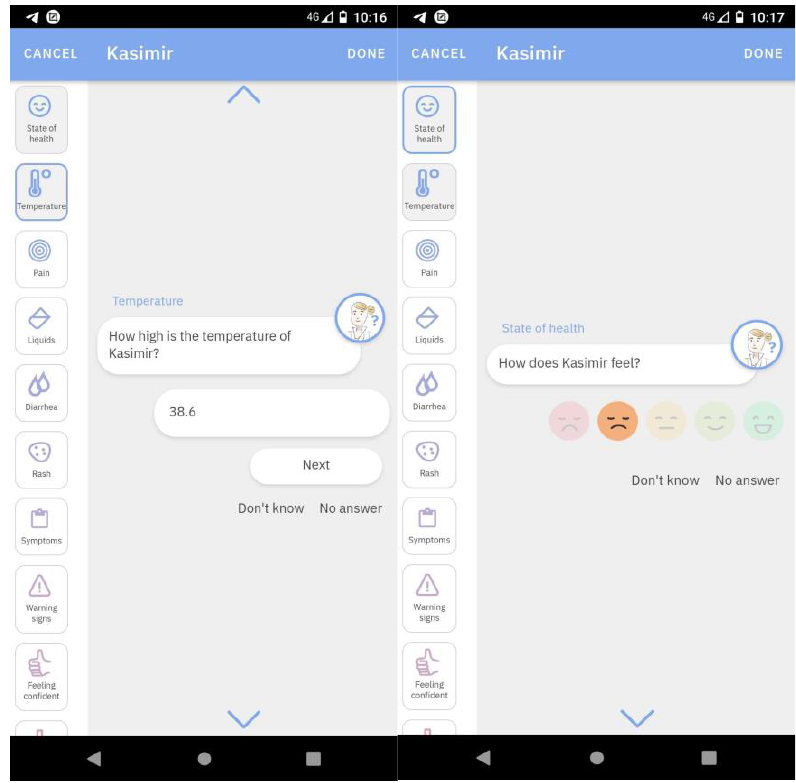
Figure 1. App design sample: Questions about well-being and temperature of a child.